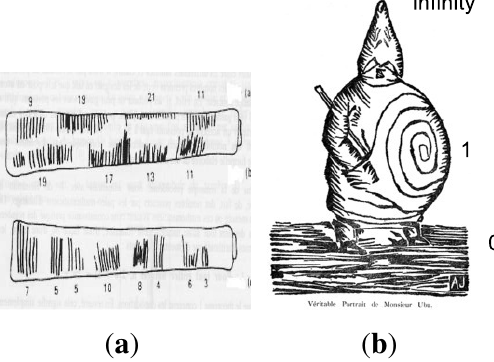
Figure 1. ( a ) A schematic of the notches on the Ishango bone; ( b ) Véritable Portrait